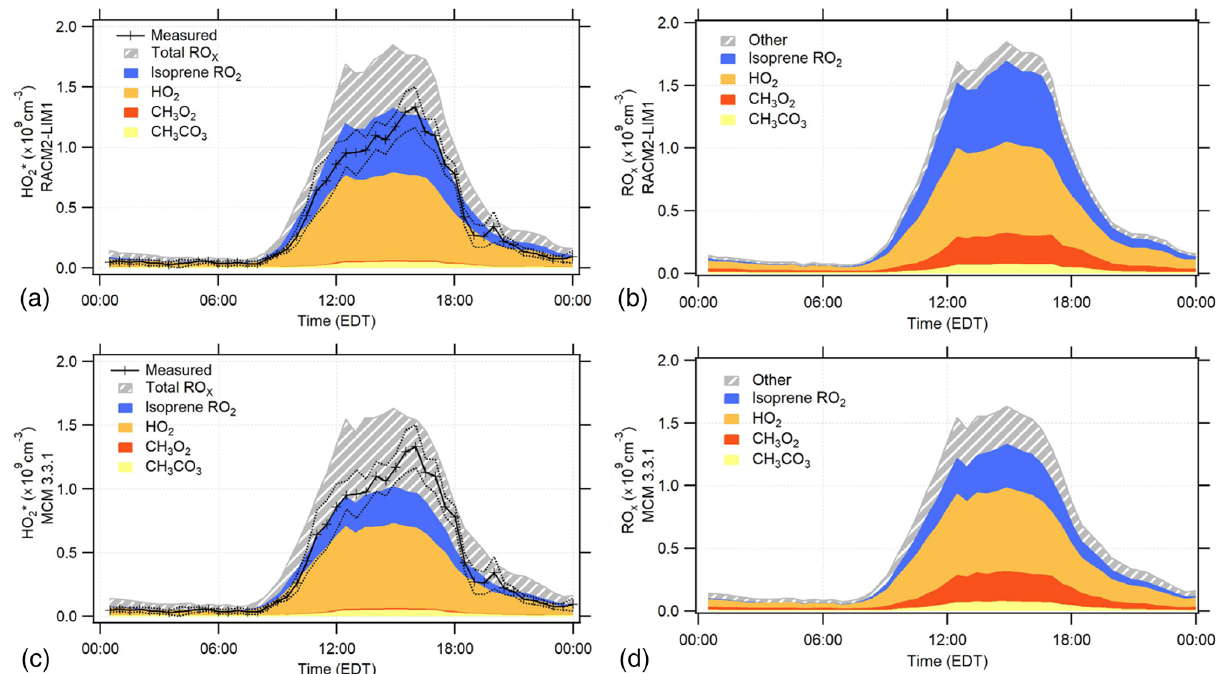
Figure 6. The RACM2-LIM1 and MCM 3.3.1 diurnal average modeled peroxy radical concentration and composition for the days when NO was measured simultaneously (see text). (a, c) The modeled contribution to the HO ∗ centrations are shown by the black line with ± 1 σ standard error of the measurements shown by the dotted lines. The calibration uncertainty of the measurements (not shown) is 38% (2 σ ). (b, d) The total RO x (RO 2 + HO 2 ) composition predicted by each model.